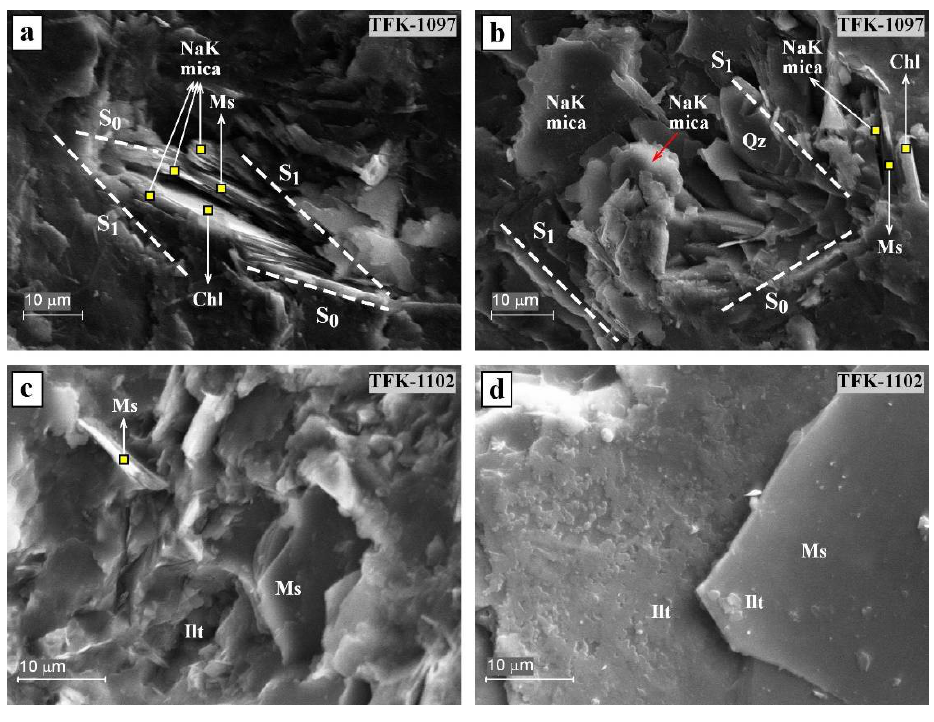
Figure 3. SEM-SE photomicrographs of the Precambrian and late Ordovician metapelitic rocks from the Eastern Tauride Autochthon. ( a , b ) Chlorite–muscovite–NaK mica stack showing its stacking planes are parallel to bedding plane (S 0 ) and high angle to cleavage (shear) planes (S 1 ). ( c , d ) The association of detrital micas and neoformed illites, which developed in voids and pores and onto the coarse-grained muscovite plates, as well.